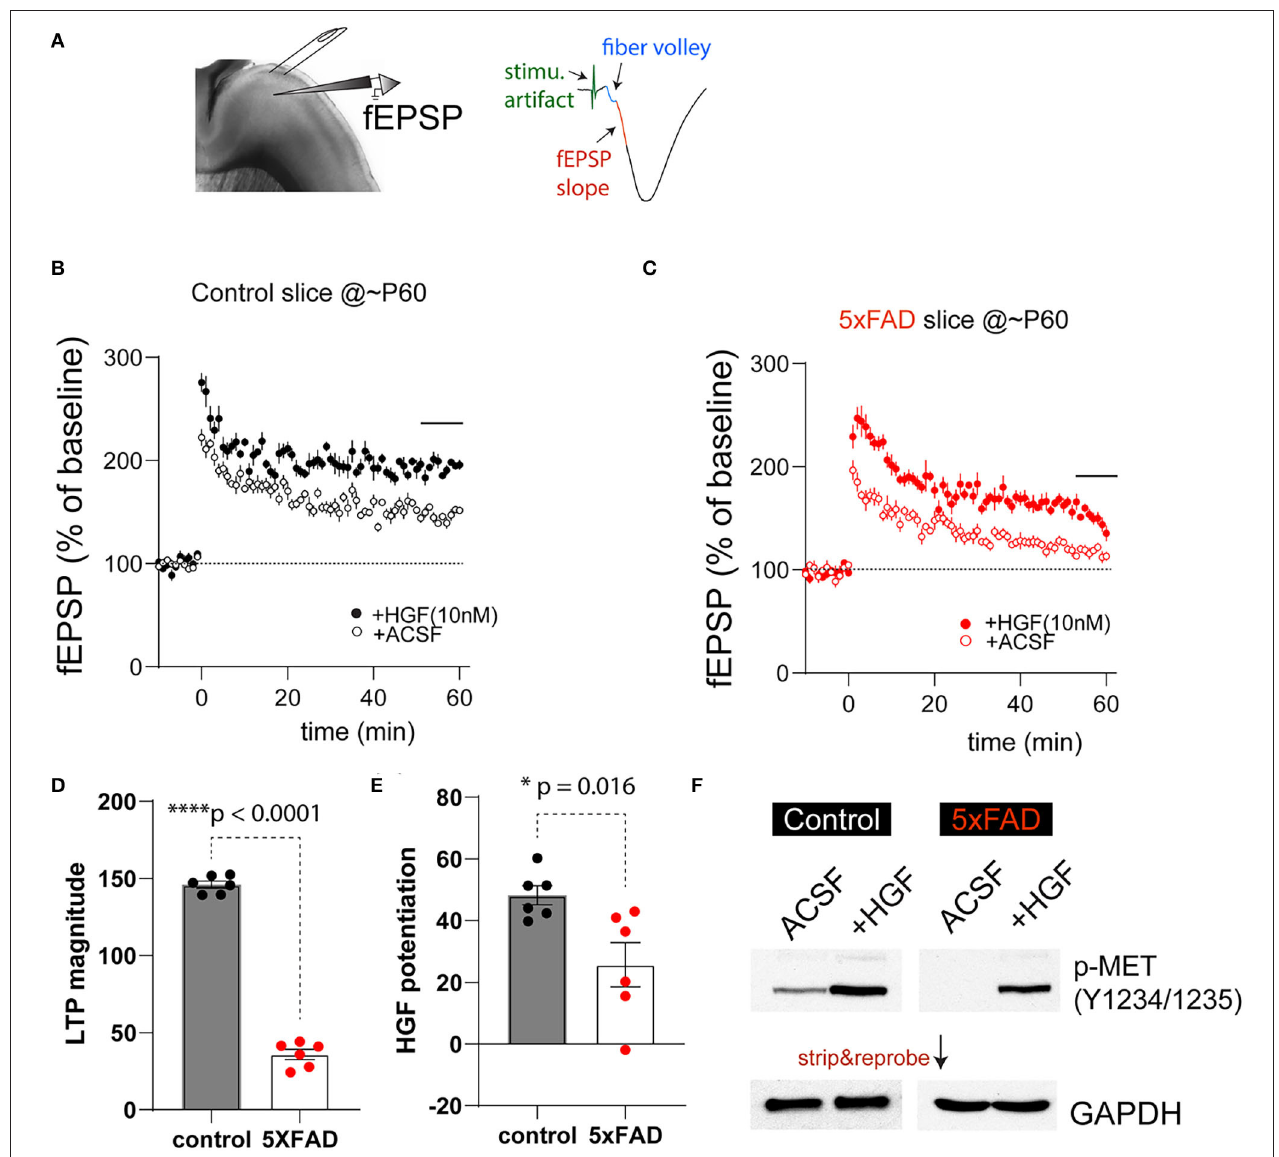
FIGURE 4 | 5XFAD mice show impaired PFC-L5 synaptic plasticity and HGF-induced LTP enhancement. (A) Schematic illustration of LTP recording in PFC-L5. A bipolar stimulating electrode was placed in L23 to elicit monosynaptic fEPSP responses ( right ). The first 1-ms fEPSP response after fiber volley was used to calculate slope of response. (B) LTP time course in control slices in the absence (ACSF) and the presence of 10nM HGF. HGF clearly elevates LTP magnitude. (C) LTP time course in 5XFAD slices in the absence (ACSF) and the presence of 10nM HGF. HGF shows smaller enhancement of LTP magnitude in 5XFAD slices compared to that from control slices. (D) Quantification of theta-burst-induced LTP magnitude in control and 5XFAD slices (last 6-min recordings were used). LTP magnitude in 5XFAD slices was dramatically reduced compared to that from control slices (**** p < 0.0001). (E) Quantification of HGF-induced potentiation of the LTP magnitude. 5XFAD slices show significantly reduced HGF-induced LTP enhancement compared to that from control slices (* p = 0.016). (F) Differential basal levels of p-MET (Y1234/1235) and HGF-induced p-MET levels in 5XFAD vs. control slices that were collected after LTP recordings. N = 4, quantification not shown.